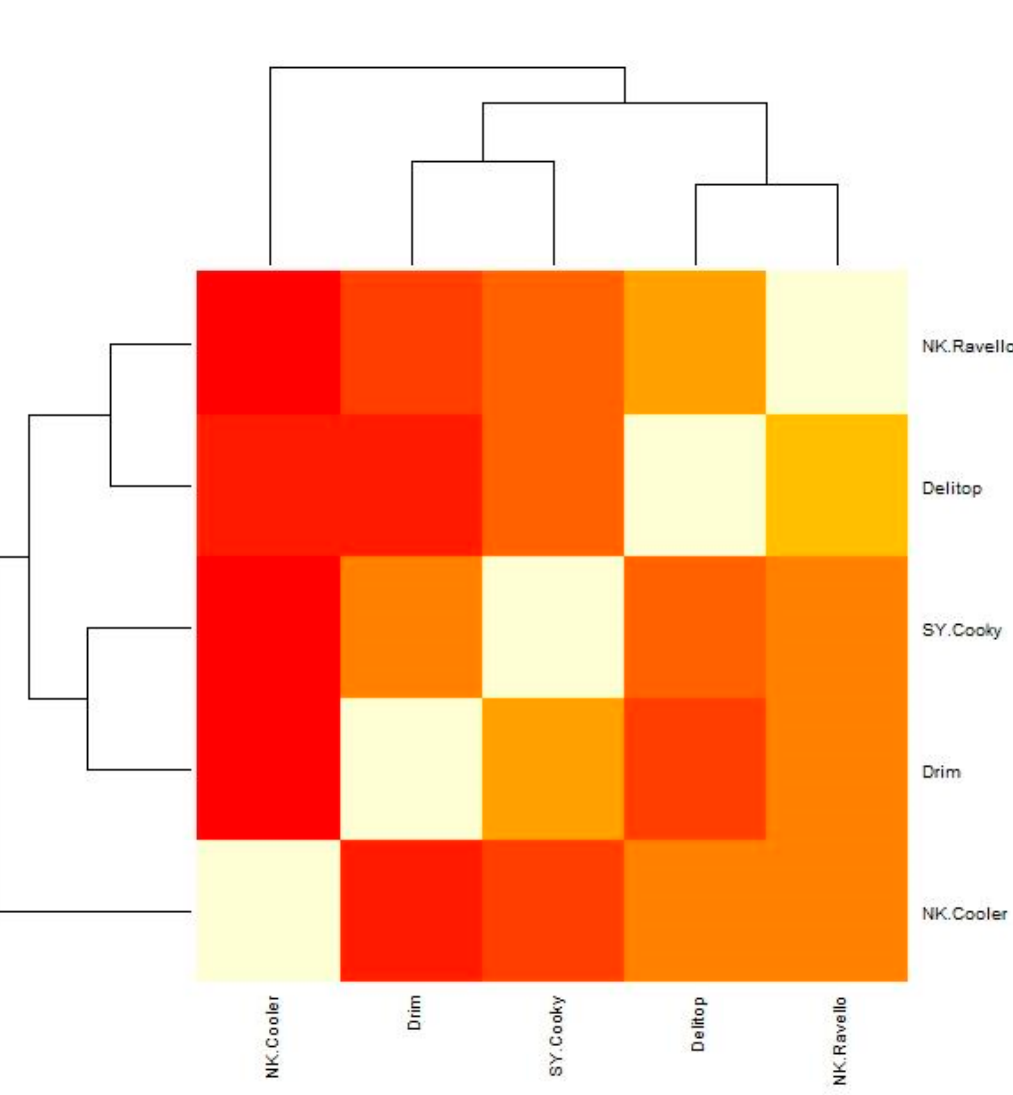
Figure 2. Heatmap of genetic similarity of five cultivars of maize constructed for 112 SSR markers. Cultivars were grouped hierarchically using the unweighted pair group method of arithmetic means